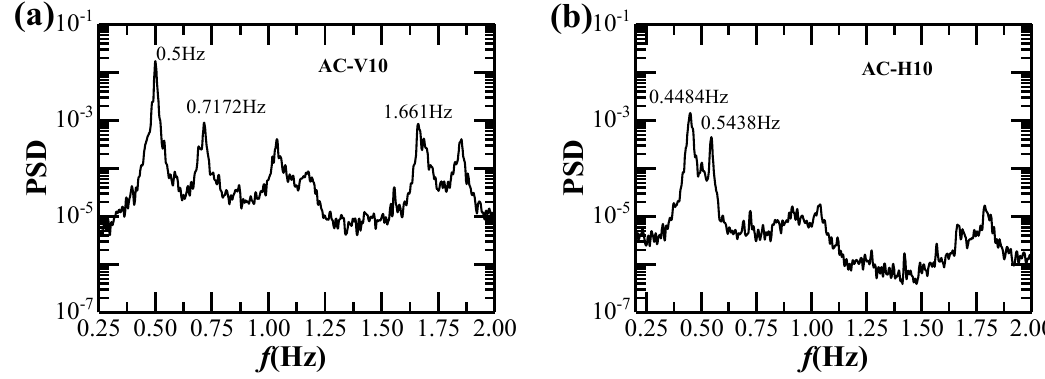
Figure 11. Acceleration spectra of the bridge girder: ( a ) Vertical; ( b ) Horizontal.